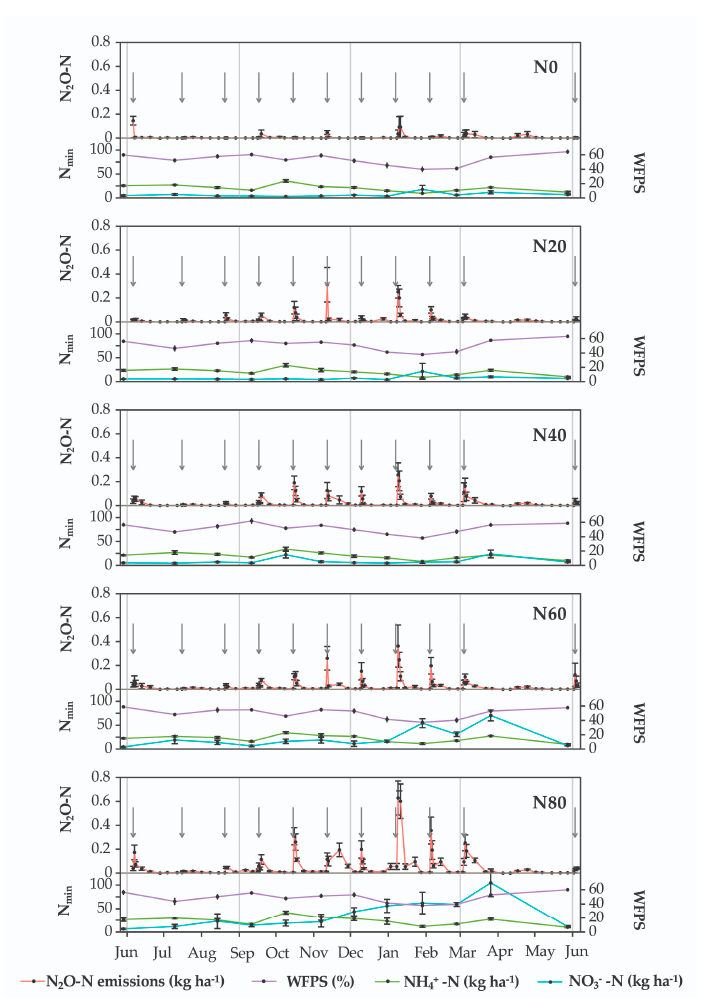
Figure 2. Daily N 2 O-N fluxes, N min (NH 4 + -N and NO 3 − -N) and WFPS for the different N fertilization (N0, N20, N40, N60, and N80) during the trial period. Arrows indicate fertilization events. The error bars denote standard errors. The N0, N20, N40, N60, and N80 refer to the different treatments used and were 0, 220, 440, 660, and 880 kg N ha − 1 year − 1 , respectively.